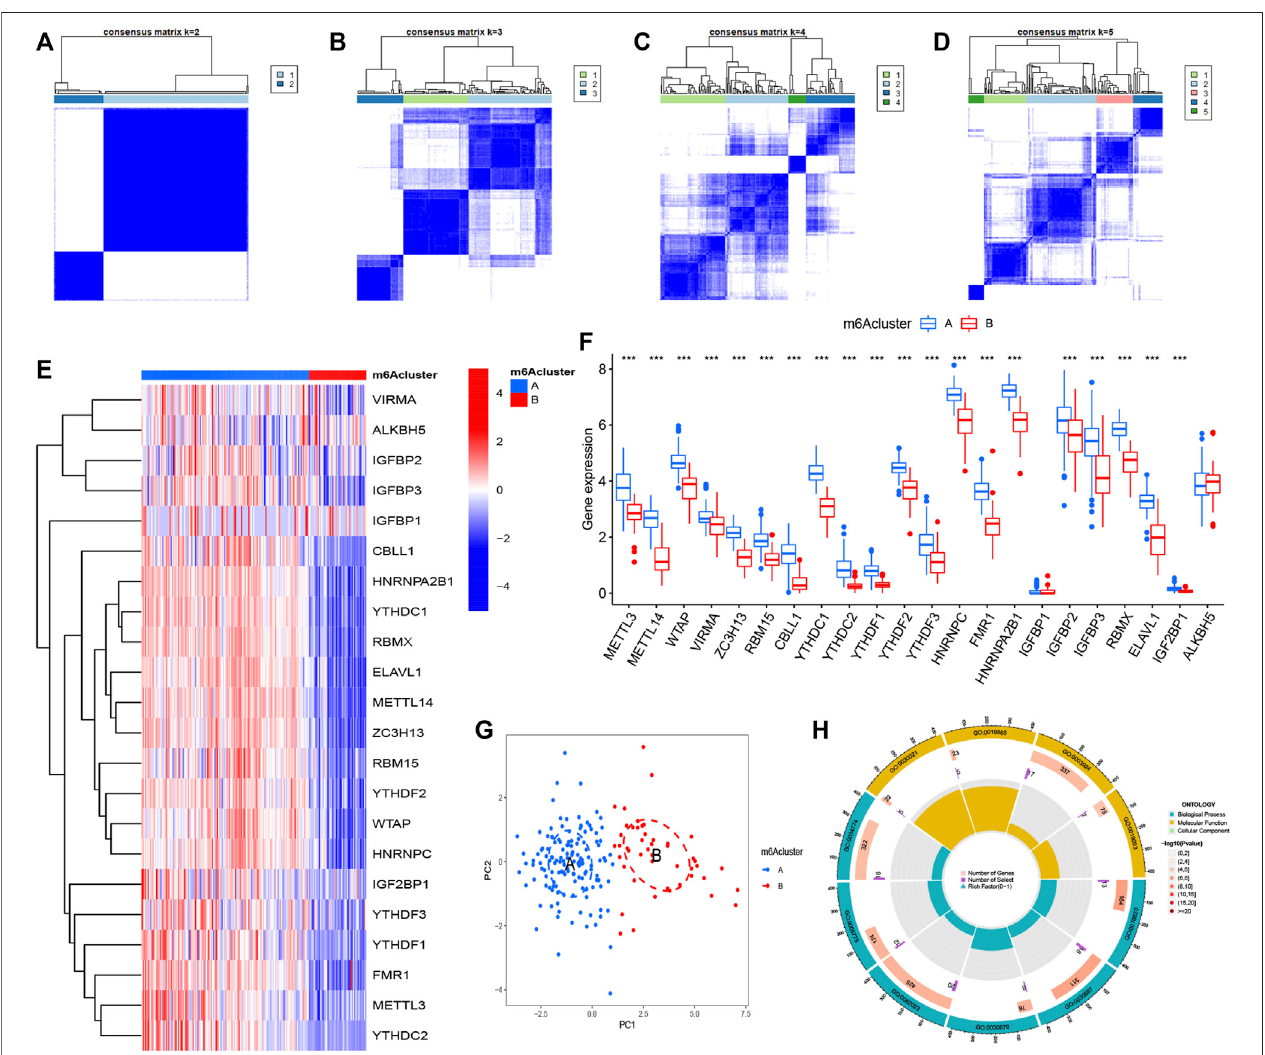
FIGURE 5 | Consensus clustering of N6-methyladenosine (m6A) regulators in treat group (CHP and IPF) (A – D) Consensus matrices of the 22 signi fi cant m6A regulators (k = 2 – 5) (E,F) Expression heatmap and histogram of the 22 signi fi cant m6A regulators in cluster A and cluster B (G) Principal component analysis for the expression pro fi les of m6A subtypes, showing a remarkable difference between different modi fi cation patterns (H) The GO enrichment analysis for the 361 m6A-related differentially expressed genes (DEGs) uncovered potential mechanisms for the occurrence and development of the treatment group. * p < 0.05, ** p < 0.01, and *** p < 0.001.